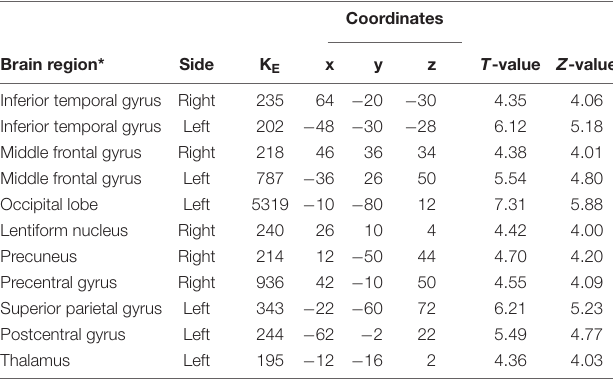
TABLE 3 | Regions with increased glucose metabolism in Meige syndrome in 6 months after STN-DBS surgery.